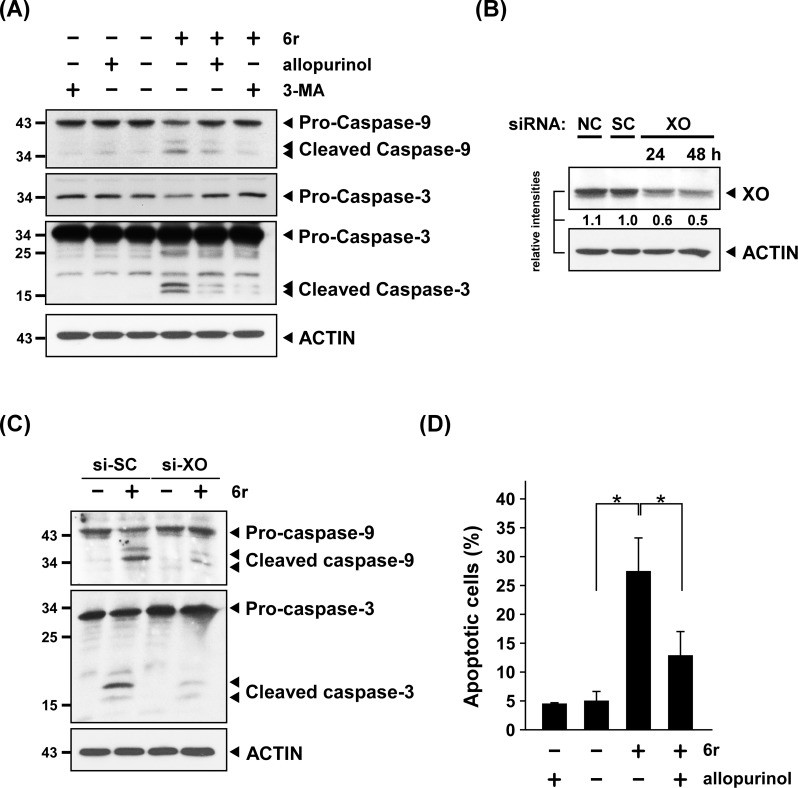
CTSS inhibition-induced early ROS contributes to mitochondria-dependent apoptotic signaling.(A) Allopurinol treatment reduced 6r-induced caspase-9/-3 activation. Cells with and without allopurinol pretreatment were incubated with 20 μM of 6r for 24 h, and subjected to western blot analysis for detecting cleaved caspase-9 and caspase-3. (B) Inhibition of XO expression by siRNA silencing approach. Cells transfected only with RNAiMax was used as a negative control (siNC) and transfected with scramble negative siRNA was used as a scramble control (siSC). (C) Reducing the expression of XO by siRNA decreased 6r-induced caspase-9/-3 activation. After 48 h of siRNA knockdown of XO, cells were treated with 20 μM of 6r for 24 h and the levels of cleaved caspase-9/-3 were assessed by western blotting. (D) Allopurinol treatment reduced the number of 6r-induced apoptotic cells. After pretreatment with allopurinol for 1 h and cotreatment with 6r for 24 h, the numbers of apoptotic cells were determined by Annexin V/PI double staining and quantified by flow cytometry. Differences were found to be statistically significant at *P < 0.05.